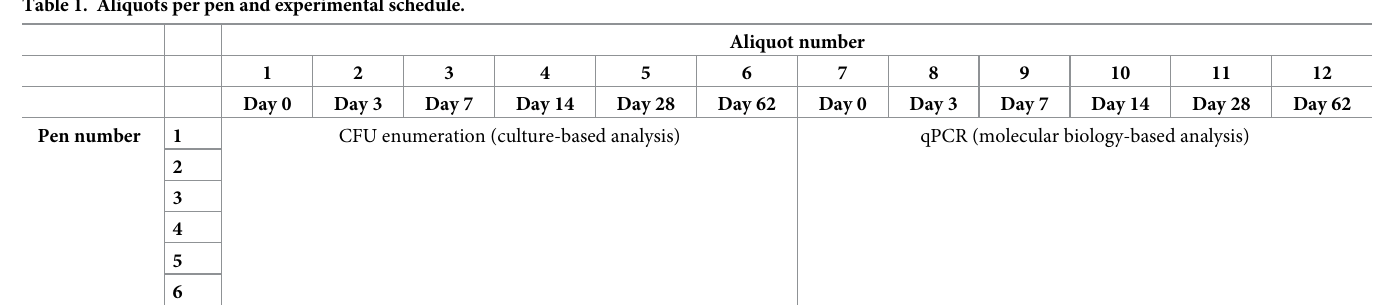
Table 1. Aliquots per pen and experimental